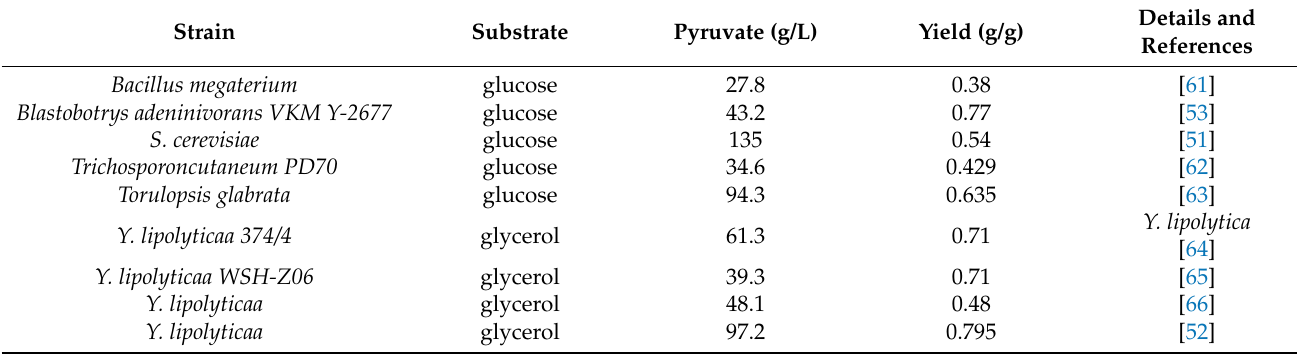
Table 2. Yeast and other microorganisms for the production of